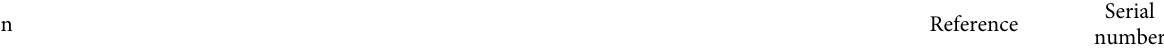
Table 3: LS factor